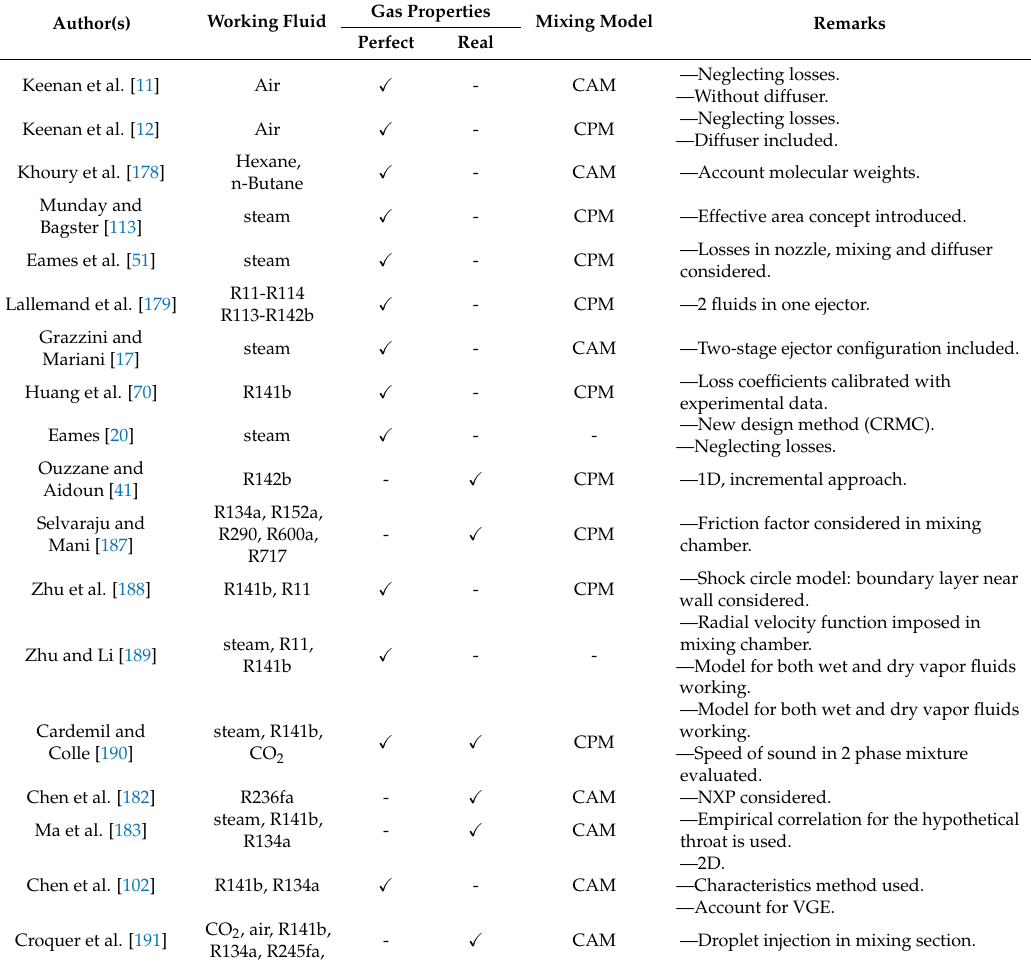
Table 2. Representative samples of thermodynamic models in the literature.